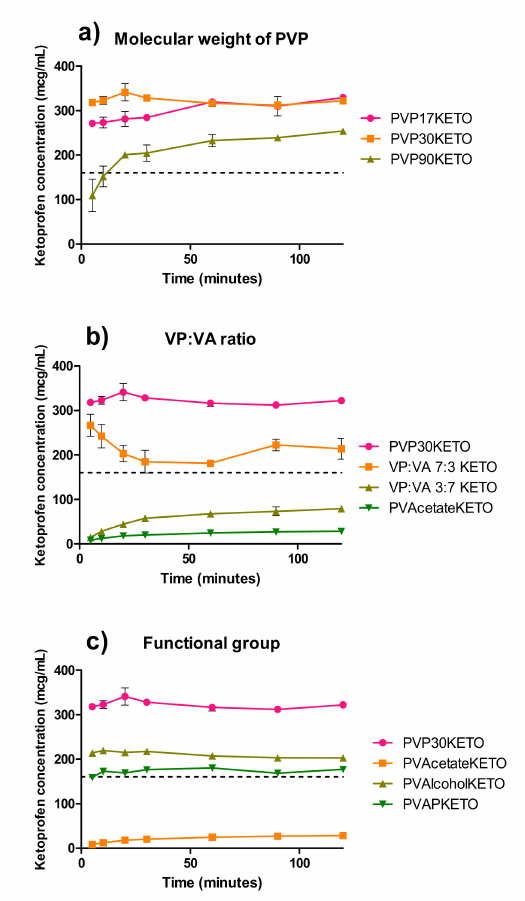
Figure 10. Dynamic solubility of POLYMERKETO systems at pH 1.2 and 37 ◦ C over two hours for ( a ) PVPKETO systems, ( b ) VP:VA KETO systems and ( c ) PVAlcoholKETO and PVAPKETO systems. The dashed line represents the equilibrium solubility of crystalline